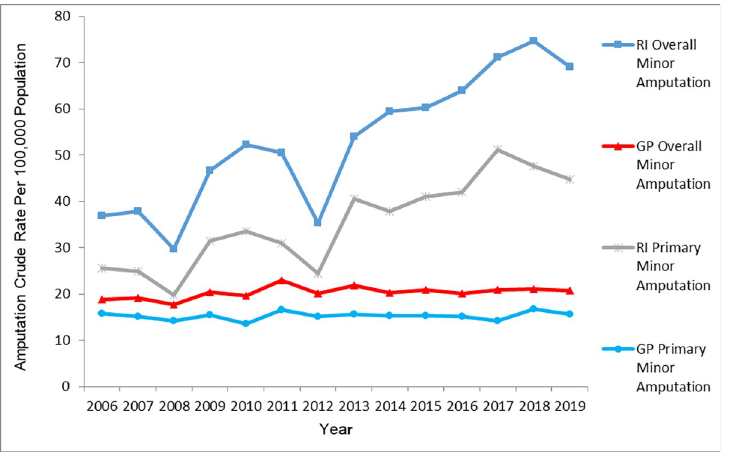
Fig 3. RI and GP overall and primary minor amputation crude rates